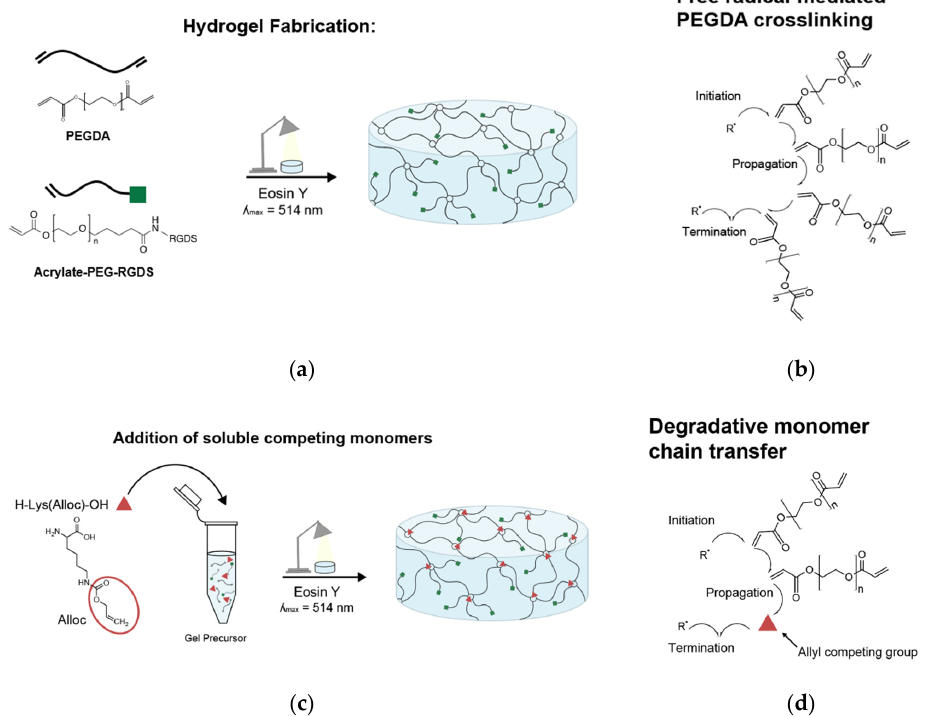
Figure 1. PEGDA hydrogel fabrication and crosslinking schematic ( a ) PEGDA + PEG-RGDS hydrogel fabrication; ( b ) addition polymerization reaction occurring at crosslinking sites in control gels; ( c ) PEGDA + PEG-RGDS + H-Lys(alloc)-OH gel fabrication; ( d ) acrylate—alloc crosslinking competition.